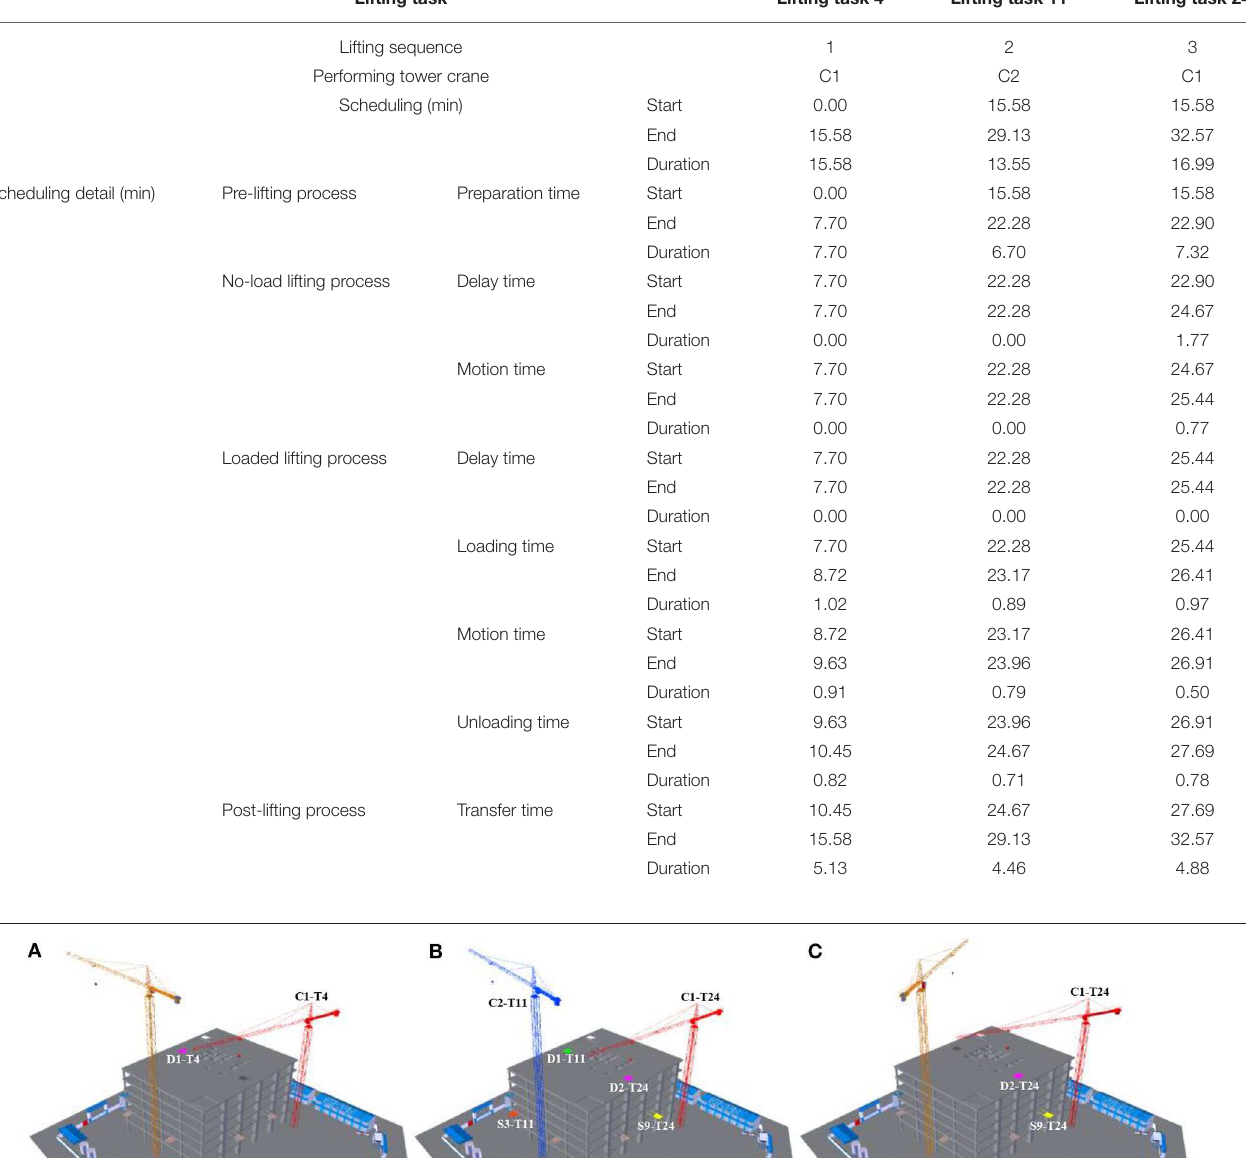
TABLE 6 | Details of the first three tasks of Search 5.